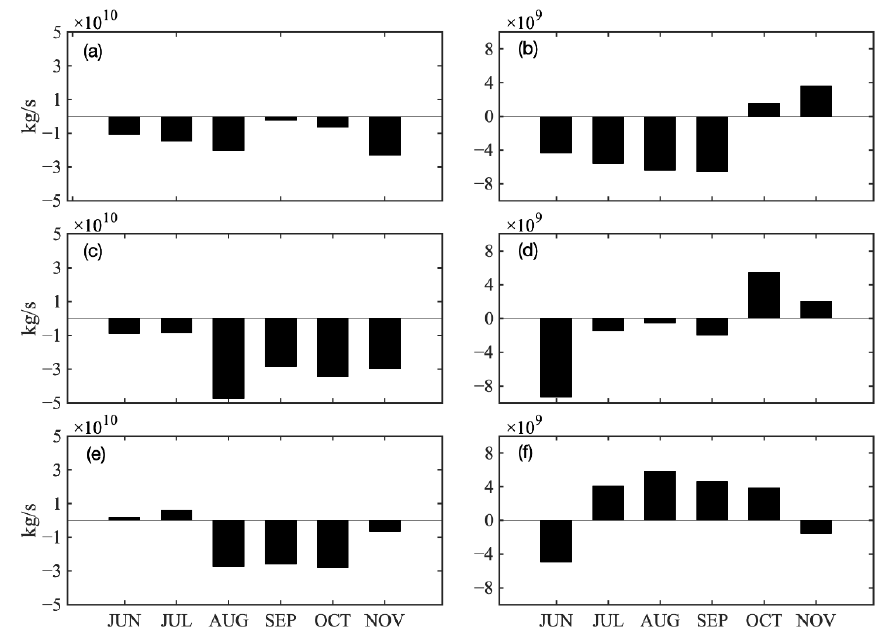
Figure 9. The freshwater transport in section A (80–83 ◦ E, 10 ◦ N; a , c , e ) and salinity transport in section B (90–98 ◦ E, 12 ◦ N; b , d , f ) marked in Figure 3 from June to November. The panels from top to bottom correspond to the climatological transports, transports in 2010 and anomalous transports in 2010 (the second panel minus the first panel).